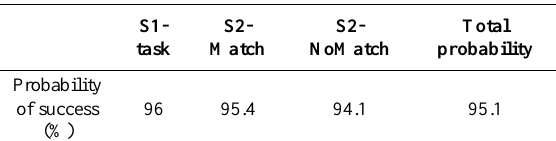
Table 2. Mean probability of success in the key generation for tasks for all individuals of the 18-channel system.